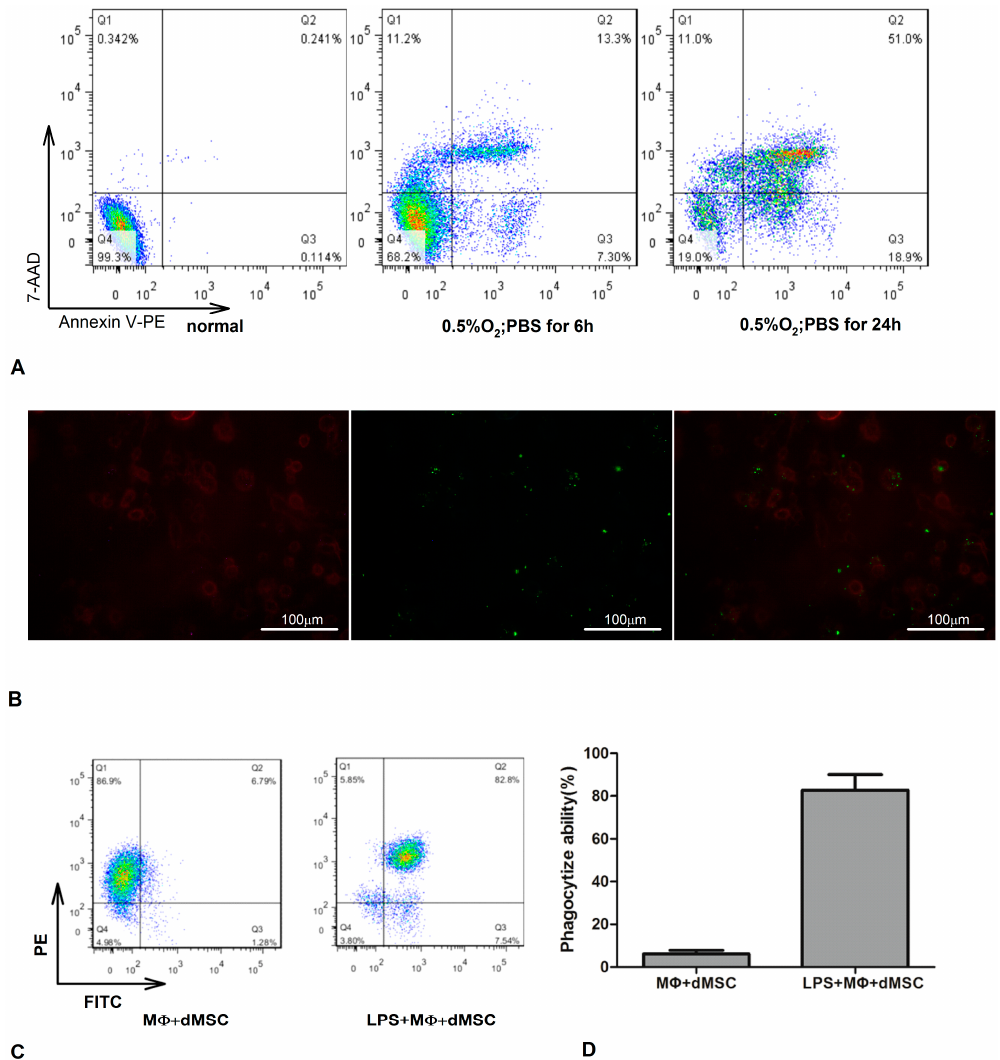
Figure 1. Dead mesenchymal stem cells (dMSCs) were phagocytosed by lipopolysaccharide (LPS)-stimulated macrophages. dMSC labeled with FITC-green fluorescent protein (GFP) and activated macrophages (2:1) stained with PE-F4/80 were co-cultured for 48 h, and then detected by fluorescence microscopy and flow cytometry (FCM). ( A ) MSCs were cultured with three conditions, including no hypoxia and 10% fetal bovine serum (FBS), 0.5% O 2 for 6 h and phosphate buffered saline (PBS), 0.5% O 2 for 24 h and PBS. The ratio of dMSCs was the greatest in third group; ( B ) Fluorescence microscopy was used to show the phenomenon of phagocytosis; ( C , D ) Phagocytosis ability of macrophage was evaluated by FCM. Significant difference was shown in two groups with or without LPS ( p < 0.001), and the mean phagocytosis rate (%) of LPS-stimulated macrophage was 80%. The percentage of each group and each bar represents the mean value of triplicate results, which means three independent experiments were done. M Φ : macrophage.